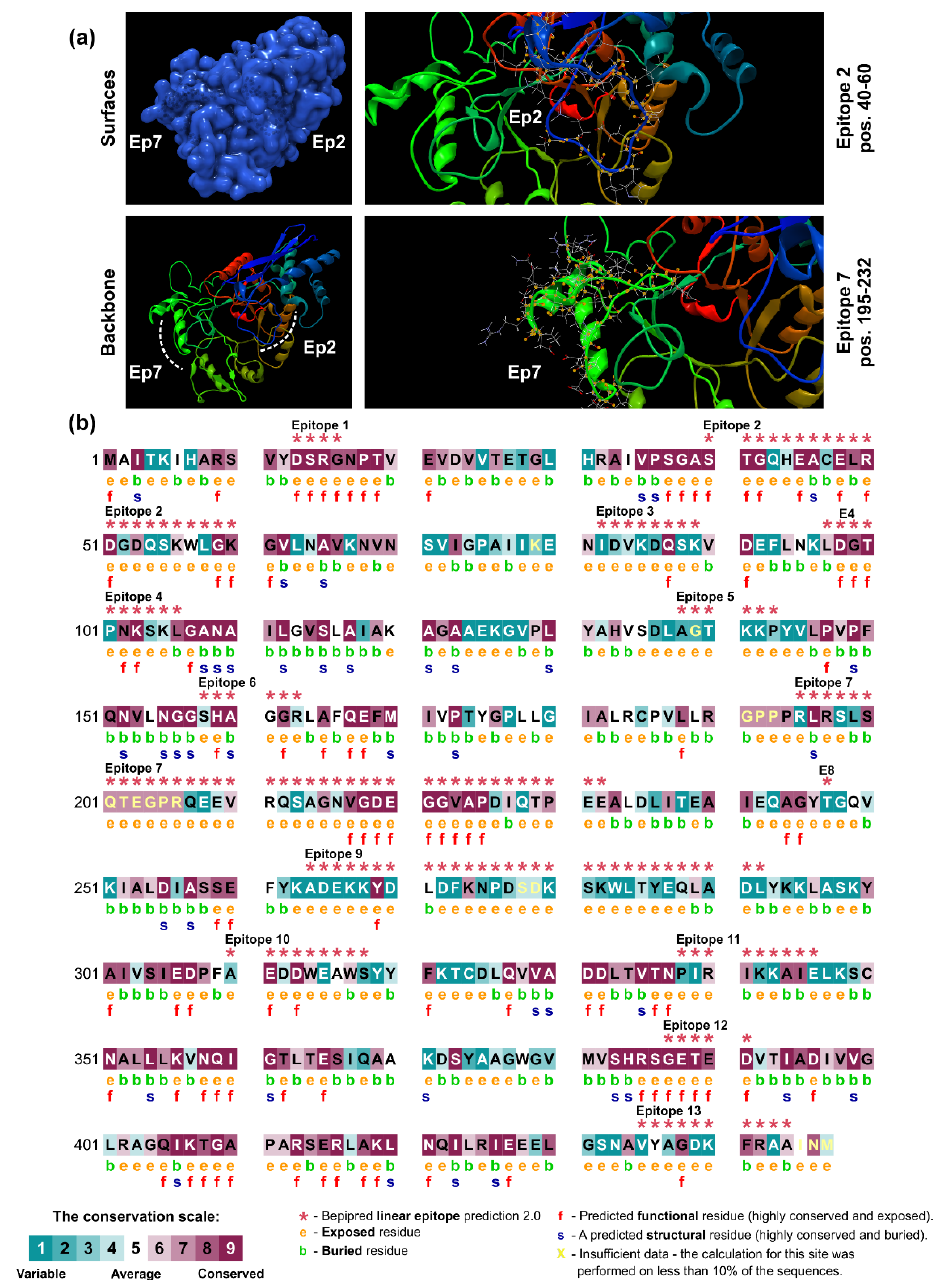
Figure 8. B-cell epitopes are exposed in the P. lutzii enolase. A comparative model for enolase was obtained from the Protein Data Bank (PDB; http://www.rcsb.org/pdb/) webserver [84] , and the Saccharomyces cerevisiae enolase 1 (strain ATCC 204508/S288c; PDB ID: 1EBG) [83] , showing a sequence identity of 70.81%, was selected as a template model. ( a ) Protein surface view (blue) based on prediction ( p = 5.1 × 10 − 12 ) using RaptorX [80] . Epitope 2 (Ep2) and epitope 7 (Ep7) are exclusive of P. lutzii and are indicated in the zoom area. A yellow dot indicates amino acid residues in the epitopes. ( b ) ConSurf analysis of the enolase protein structure of P. lutzii (accession number: XP_015703472) reveals that the 13 predicted B-cell epitopes (red asterisks) match exposed residues. Amino acid residues are color coded by their conservation grades using a nine-grade color-coding bar (bin 1 to 9), with turquoise-through-maroon indicating variable through conserved. The conservation calculation was performed on a sample of 150 sequences representing the list of homologs to the query XP_015703472. The figure also reveals the functionally and structurally important regions of the